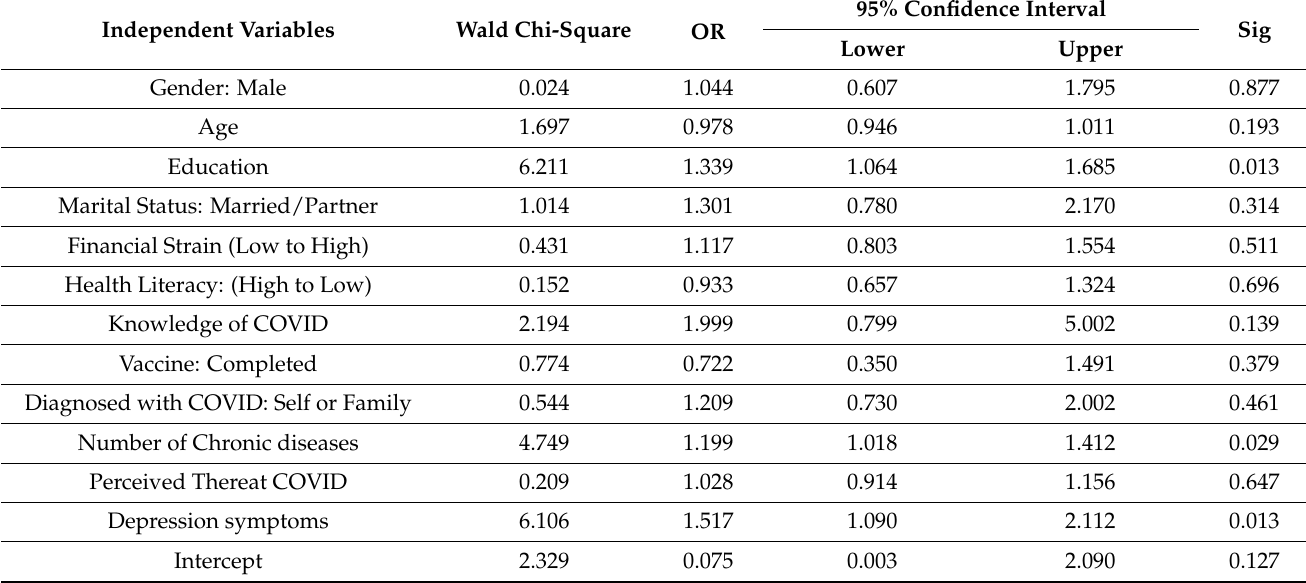
Table 3. Poisson Log-Linear Regression, the Odds Ratio (OR) and 95% Confidence